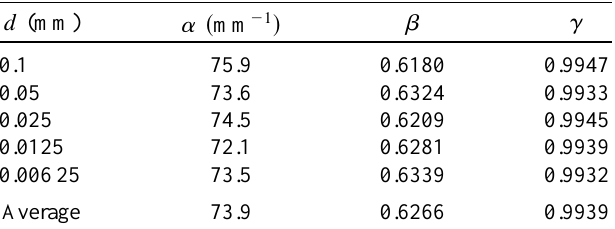
TABLE I. Fitting constants a , b , and g [see Eq. (3)] for random multipoles generated by random block displacements for the six-block coil of the main LHC dipole